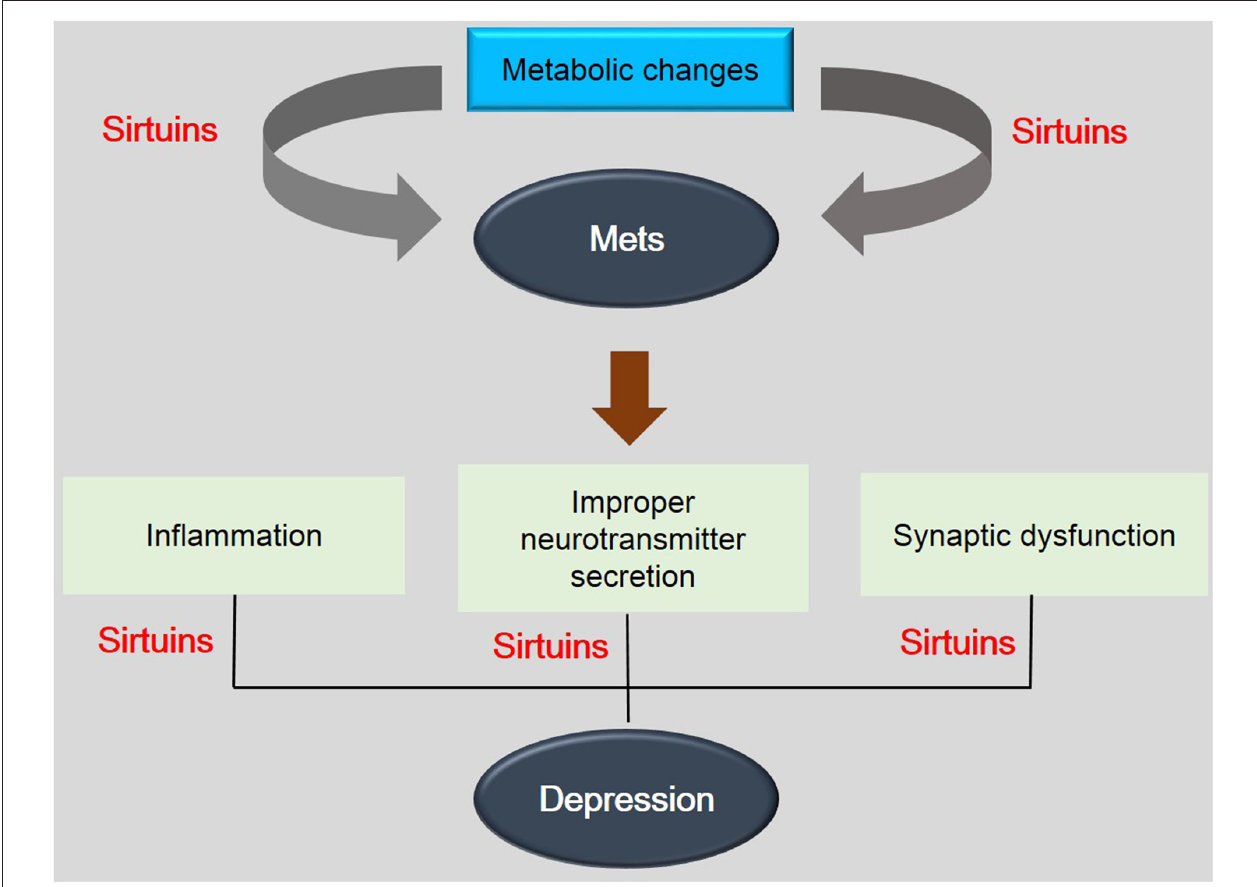
FIGURE 2 | The association between depression and metabolic diseases. This schematic image shows the association between depression and metabolic diseases. SIRTs are involved in the pathogenesis of metabolic disease by metabolic changes and also are related with depression related phenomenon. This image indicates the importance of SIRTs in mechanisms between depression and metabolic diseases. Mets: Metabolic disorders.